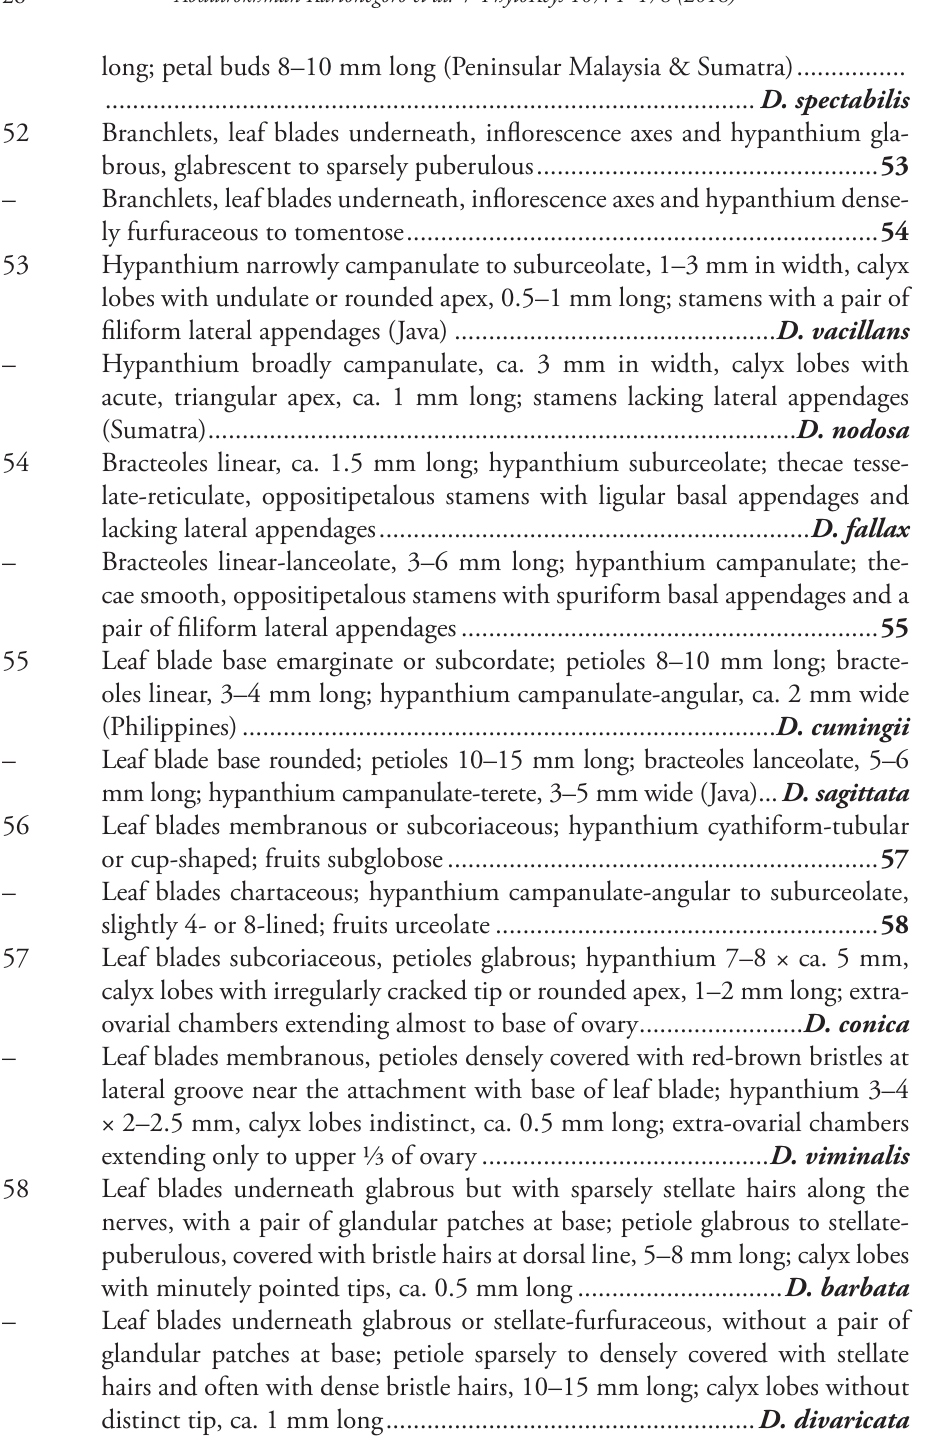
Branchlets, leaf blades underneath, inflorescence axes and hypanthium gla- brous, glabrescent to sparsely puberulous .................................................. 53 – Branchlets, leaf blades underneath, inflorescence axes and hypanthium dense- ly furfuraceous to tomentose ..................................................................... 54 53 Hypanthium narrowly campanulate to suburceolate, 1–3 mm in width, calyx lobes with undulate or rounded apex, 0.5–1 mm long; stamens with a pair of filiform lateral appendages (Java) ............................................... D. vacillans – Hypanthium broadly campanulate, ca. 3 mm in width, calyx lobes with acute, triangular apex, ca. 1 mm long; stamens lacking lateral appendages (Sumatra) ...................................................................................... D. nodosa 54 Bracteoles linear, ca. 1.5 mm long; hypanthium suburceolate; thecae tesse- late-reticulate, oppositipetalous stamens with ligular basal appendages and lacking lateral appendages ............................................................... D. fallax – Bracteoles linear-lanceolate, 3–6 mm long; hypanthium campanulate; the- cae smooth, oppositipetalous stamens with spuriform basal appendages and a pair of filiform lateral appendages ............................................................. 55 55 Leaf blade base emarginate or subcordate; petioles 8–10 mm long; bracte- oles linear, 3–4 mm long; hypanthium campanulate-angular, ca. 2 mm wide (Philippines) .............................................................................. D. cumingii – Leaf blade base rounded; petioles 10–15 mm long; bracteoles lanceolate, 5–6 mm long; hypanthium campanulate-terete, 3–5 mm wide (Java) ... D. sagittata 56 Leaf blades membranous or subcoriaceous; hypanthium cyathiform-tubular or cup-shaped; fruits subglobose ............................................................... 57 – Leaf blades chartaceous; hypanthium campanulate-angular to suburceolate, slightly 4- or 8-lined; fruits urceolate ........................................................ 58 57 Leaf blades subcoriaceous, petioles glabrous; hypanthium 7–8 × ca. 5 mm, calyx lobes with irregularly cracked tip or rounded apex, 1–2 mm long; extra- ovarial chambers extending almost to base of ovary ........................ D. conica – Leaf blades membranous, petioles densely covered with red-brown bristles at lateral groove near the attachment with base of leaf blade; hypanthium 3–4 × 2–2.5 mm, calyx lobes indistinct, ca. 0.5 mm long; extra-ovarial chambers extending only to upper ⅓ of ovary .......................................... D. viminalis 58 Leaf blades underneath glabrous but with sparsely stellate hairs along the nerves, with a pair of glandular patches at base; petiole glabrous to stellate- puberulous, covered with bristle hairs at dorsal line, 5–8 mm long; calyx lobes with minutely pointed tips, ca. 0.5 mm long .............................. D. barbata – Leaf blades underneath glabrous or stellate-furfuraceous, without a pair of glandular patches at base; petiole sparsely to densely covered with stellate hairs and often with dense bristle hairs, 10–15 mm long; calyx lobes without distinct tip, ca. 1 mm long ...................................................... D.